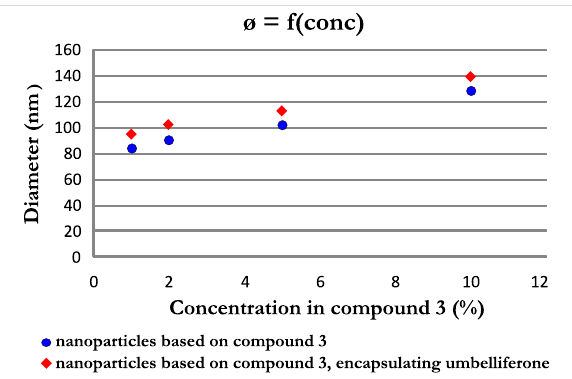
Figure 3: Diameter of the nanoparticles based on compound 3 , with and without